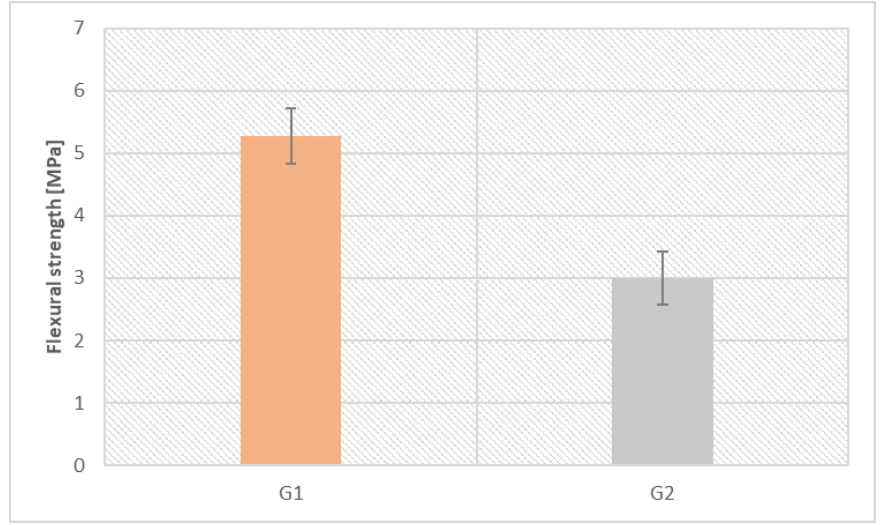
Figure 2. Flexural strength (MPa) of the samples after 28 days of curing. The samples for which metakaolin was used obtained better flexural strength — 5.28 MPa. On the other hand, the samples containing fly ash as a main component achieved a compressive strength of 3 MPa, which is an acceptable value for many applications. The results obtained are comparable with other geopolymer composites based on fly ash and metakaolin [15,34]. 3.2.2. Compressive Strength The results of the compressive strength tests for both samples are shown in Figure 3. Figure 3. Compressive strength (MPa) of the samples after 28 days of curing. In the case of compressive strength, there is no statistical difference between the sam- ples. The compressive strengths are: 20.1 MPa for samples based on metakaolin and 19.7 MPa for geopolymer composites based on fly ash. Both materials give similar values of compressive strength, which gives these materials the possibility to be applied in the building industry. Furthermore, these values are below the expected value for geopoly- mer concrete and are quite typical for geopolymer paste without fine aggregate [15,35].